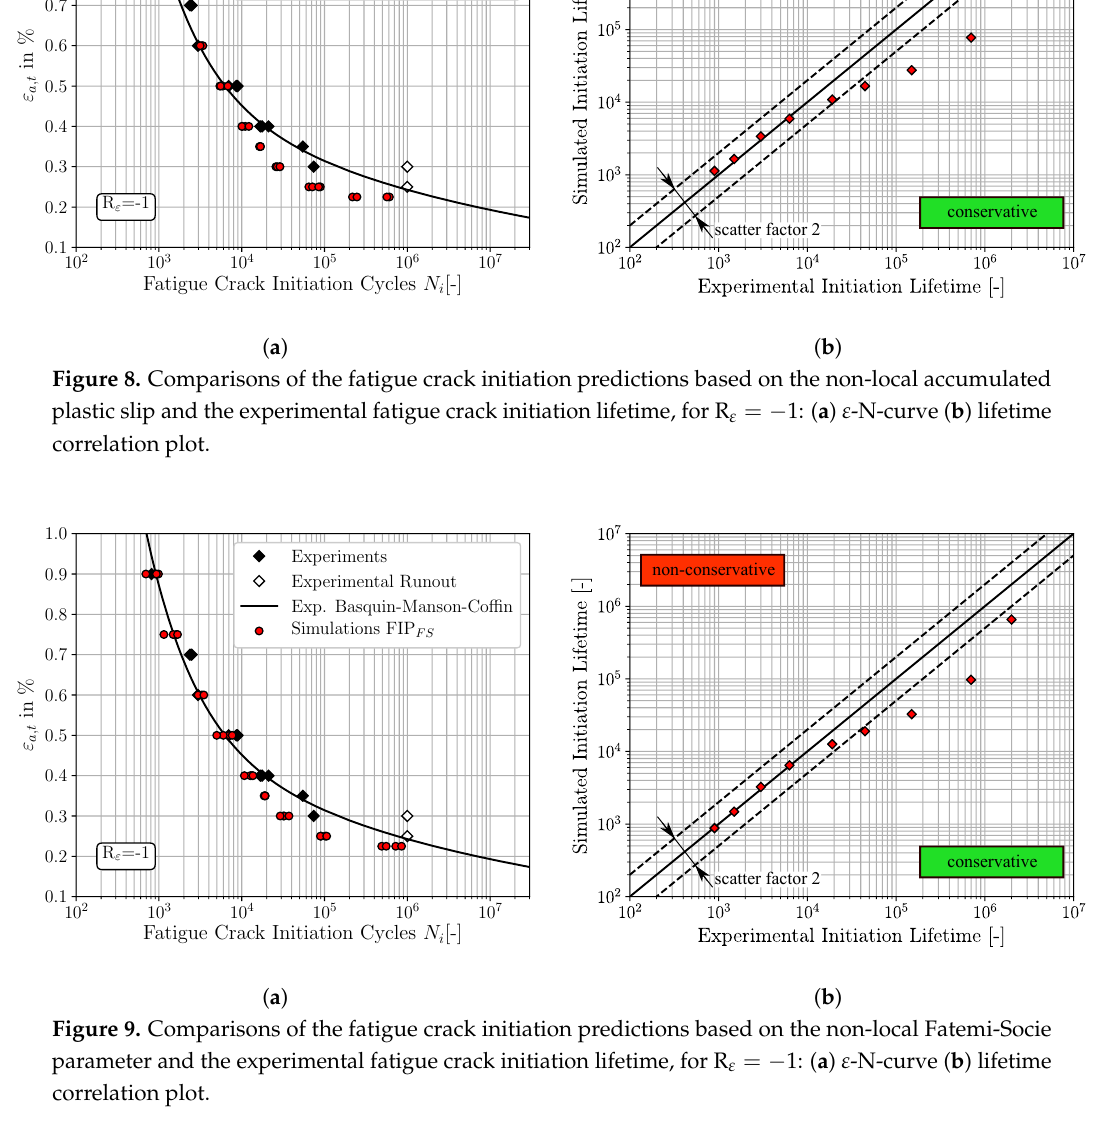
1: ( a ) ε -N-curve ( b ) lifetime −